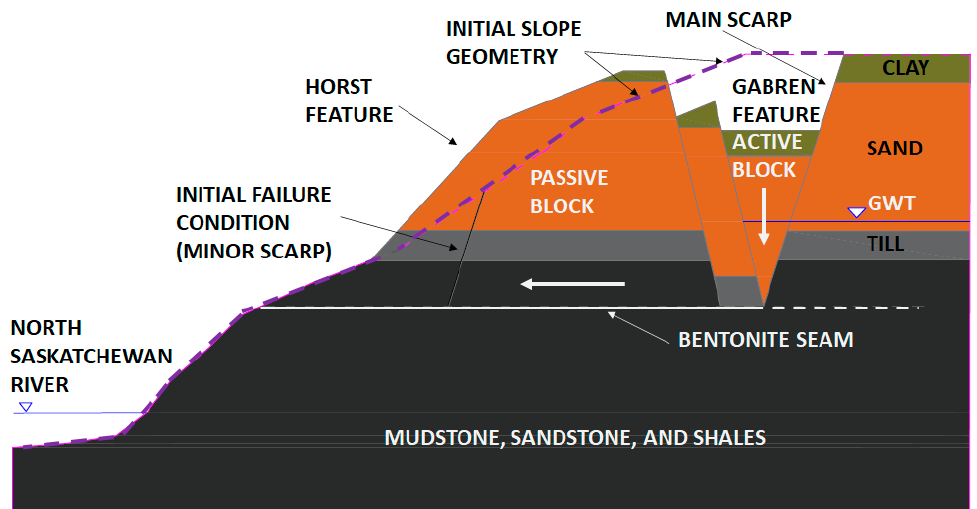
Figure 4. Whitemud road landslide kinematics during the initial stage of failure—adapted from